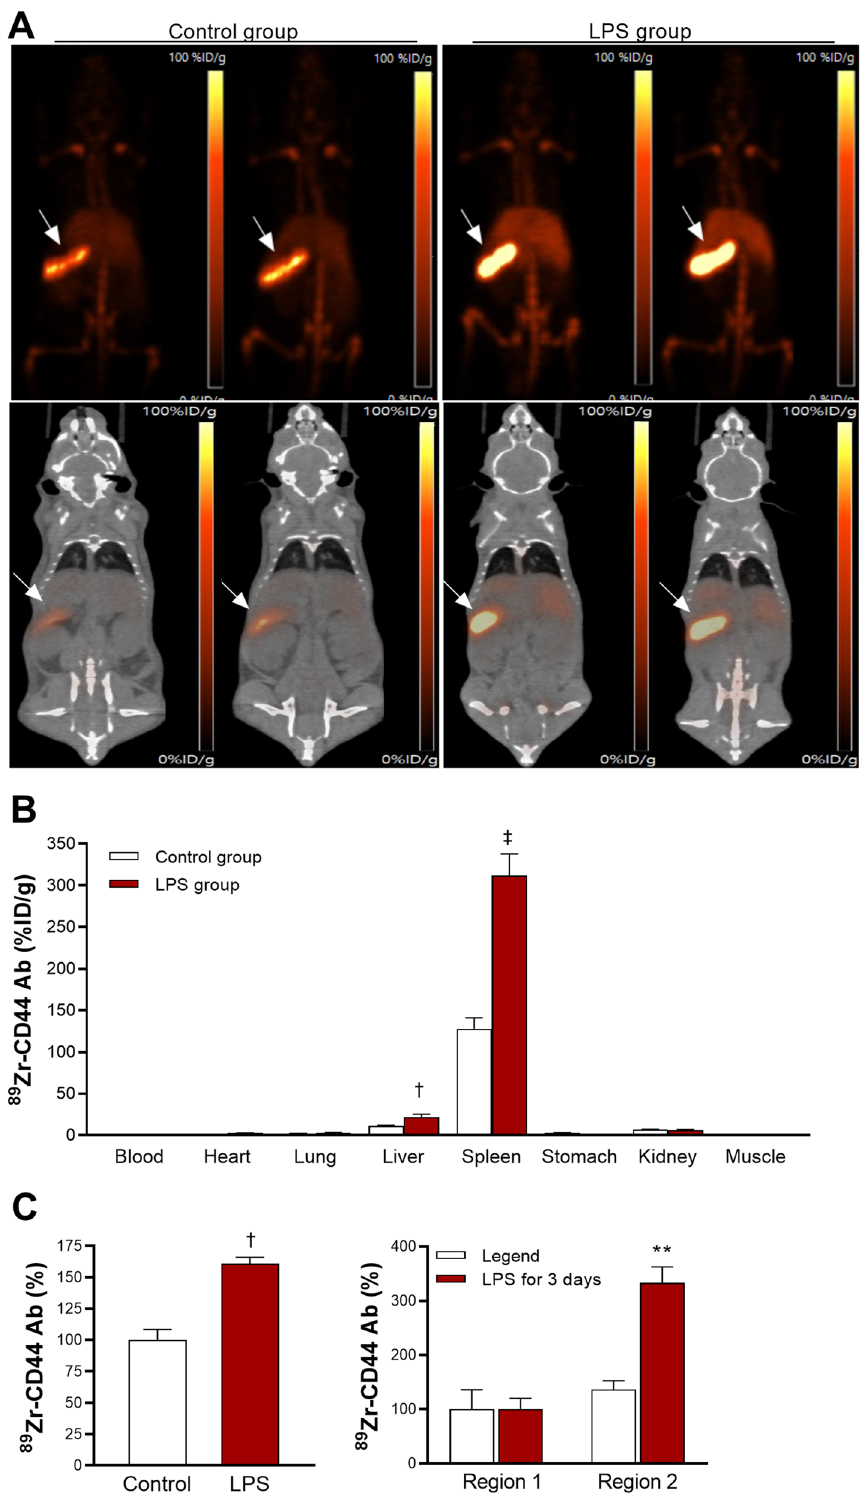
Figure 5. PET/CT imaging, biodistribution, and splenic cell binding of 89 Zr-anti-CD44. ( A ) Representative maximum intensity projection (MIP) images (top) and coronal (bottom) PET/CT images of two wild type mice per group after daily injection for 3 days with saline (control) or 50 μg/kg LPS. 89 Zr-anti-CD44 was injected on the second day, and imaging was performed 4 days later. Arrows indicate splenic uptake. ( B ) Biodistribution in saline- and LPS-treated mice immediately after PET/CT. ( C ) Effects of LPS on 89 Zr-anti-CD44 uptake in leukocytes obtained from spleens of normal naive mice. On the left are unsorted splenic leukocytes, and on the right are cells from R1 and R2. Bars are mean ± S.D. of %ID/g obtained from 4 animals per group ( B ) or % activity obtained from triplicate samples ( C ). ** P > 0.01; † P > 0.005; ‡ P > 0.001, compared to